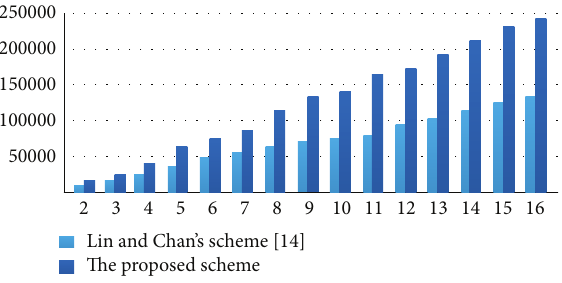
Figure 9: The comparison of the embedding